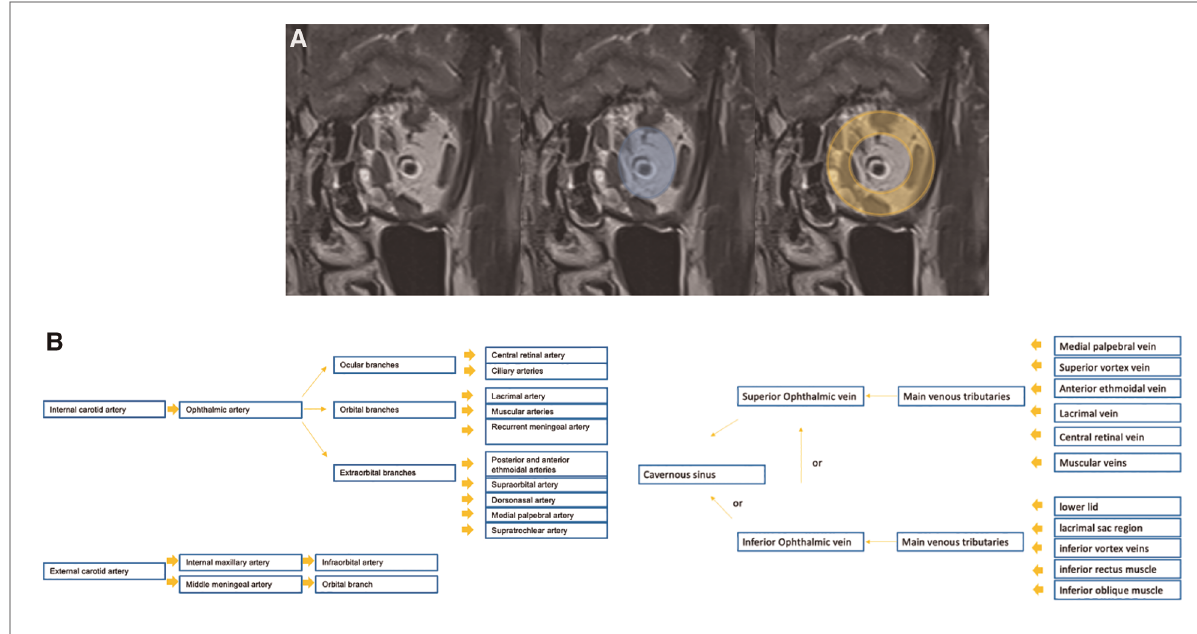
FIGURE 1 Detailed schemes of the anatomical spaces of the orbit on the coronal T2w sequence ( A : the intra-conal space is depicted in blue, while the extra- conal in orange) and of the vascular supply of the orbit ( B